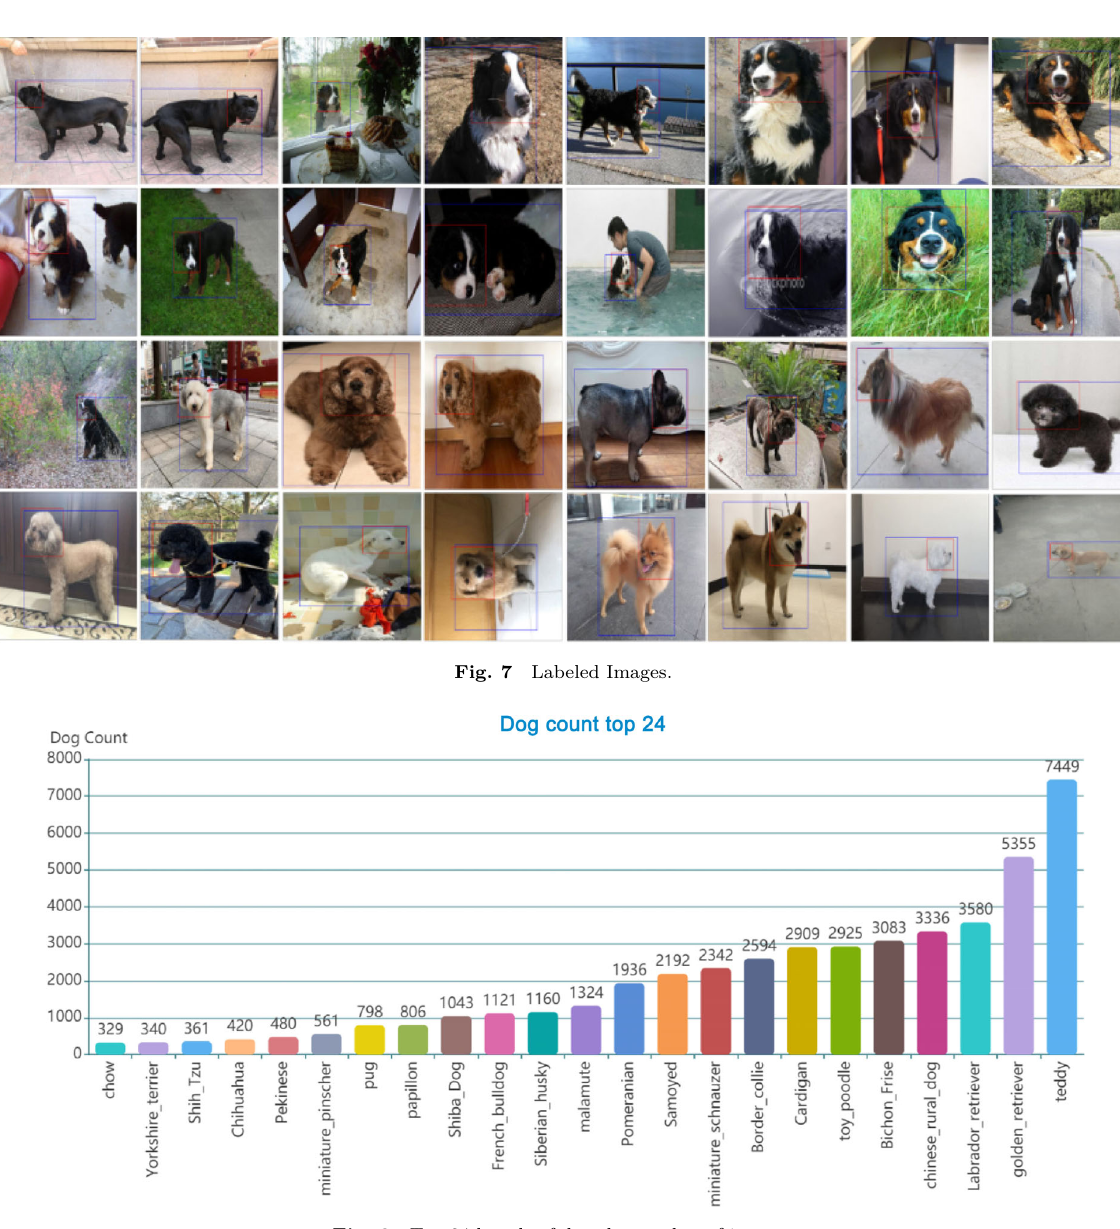
Fig. 8 Top 24 breeds of dogs by number of